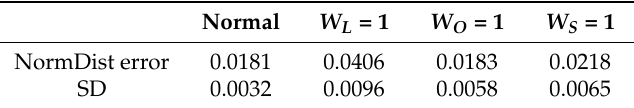
Table 1. The effect of the weights on the vanishing point detection accuracy.